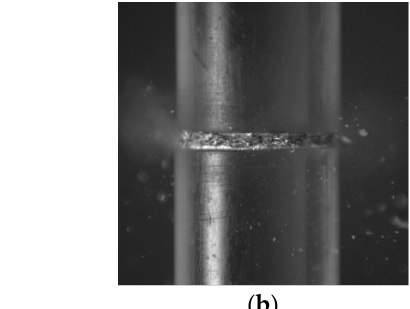
Figure 10. Increase in plateau stress depending on the volume of air trapped inside cells (based on results obtained in [21]). Table 4. Measurement results of the volume of air limited by walls in the real models of the samples.